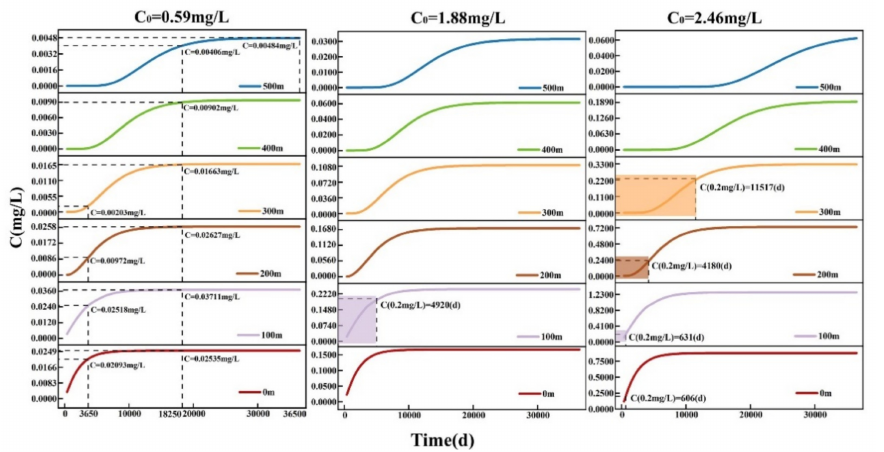
Figure 9. MT3DMS simulation results of the horizontal TP transport in the eastern part of the study area. ( a – d ) shows the transport of TP after 1 year, 10 years, 50 years, and 100 years of groundwater dispersion, respectively.